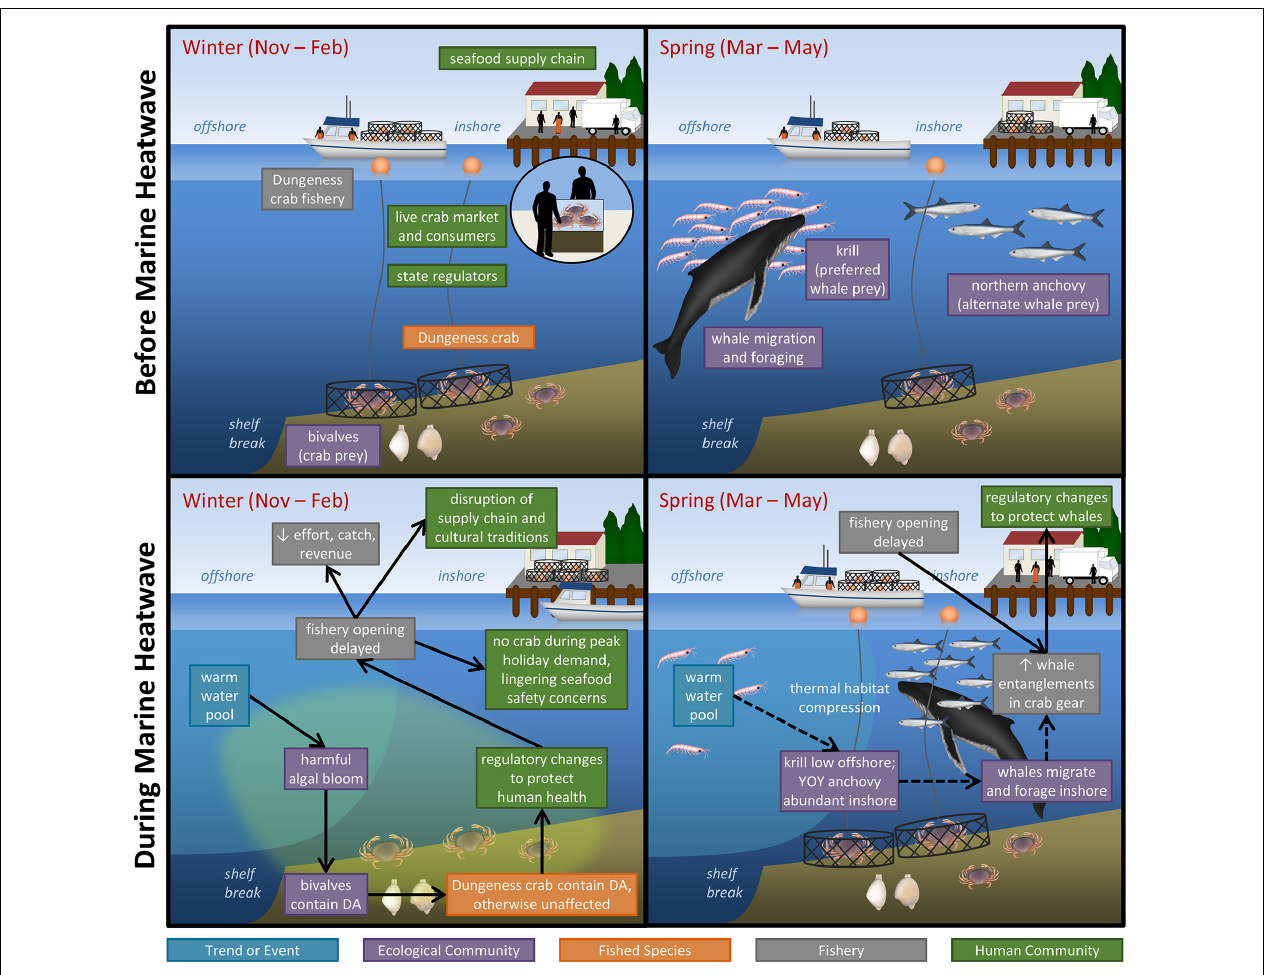
FIGURE 2 | Impacts of the North Pacific Marine Heatwave (MHW) on the California commercial Dungeness crab fishery system. Boxes are color-coded by domain and indicate the major system components (Before Marine Heatwave) and impacts of the MHW (During Marine Heatwave). Arrows connect exposures and impacts. Dashed (vs. solid) arrows indicate the two pathways by which the MHW impacted the fishery